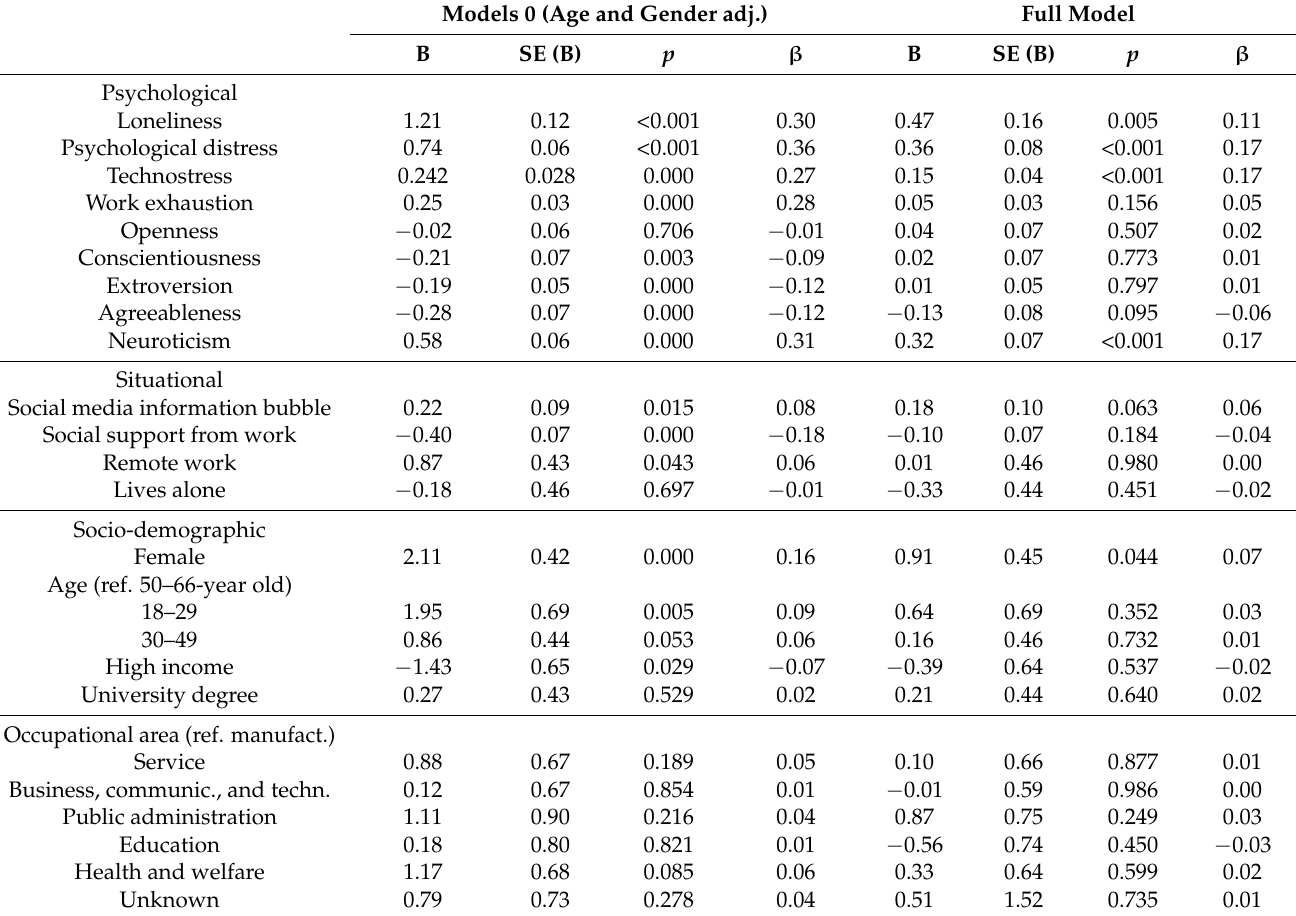
Table 2. Predictors of COVID-19 anxiety among a national sample of Finnish workers. Models 0 (Age and Gender